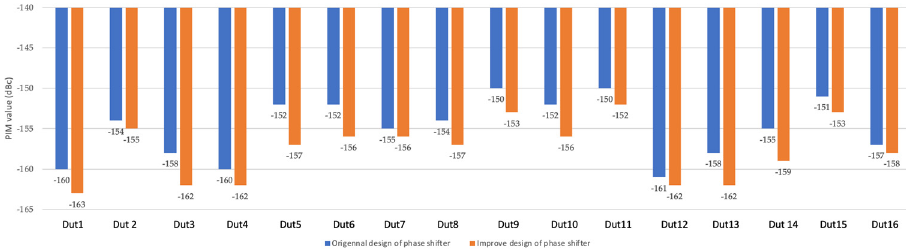
Figure 16. PIM test result comparison between original design of phase shifter and improved design of phase shifter after bending the input cables.